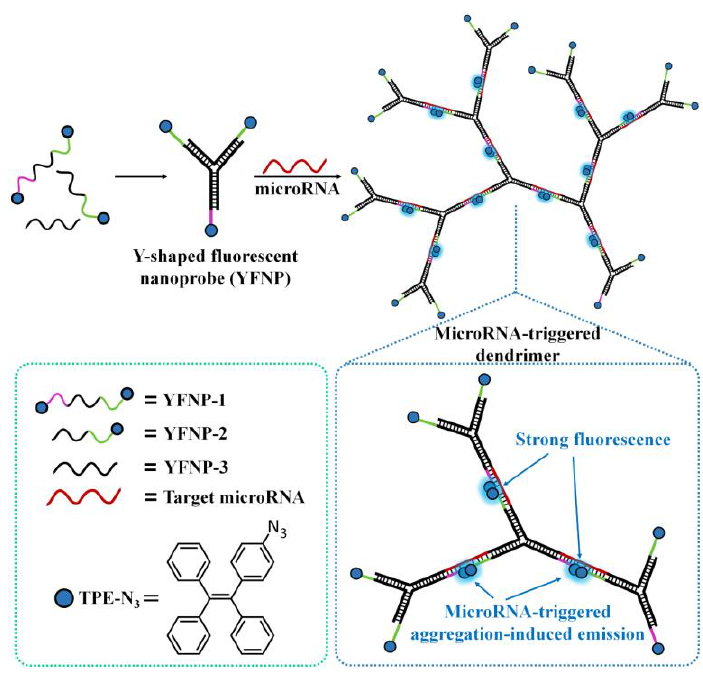
Scheme 1. Schematic representation of the YFNP for miRNA